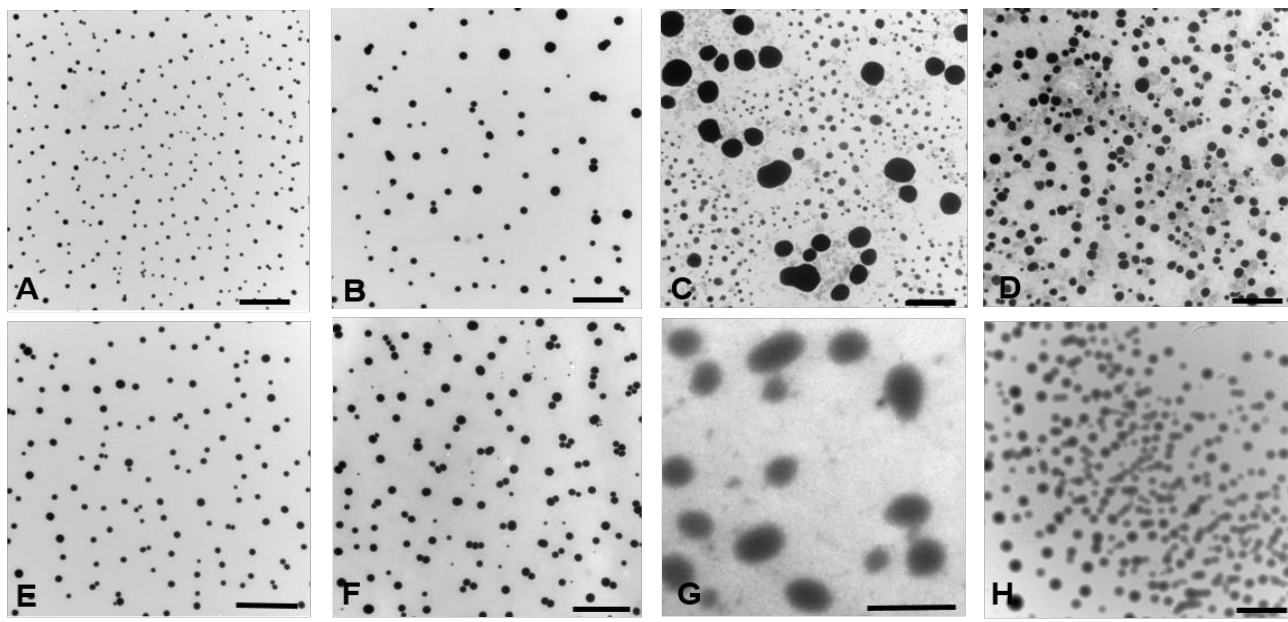
Figure 2. TEM micrographs of T1307:F127 ( A ), T1307:F127/FNZ ( B ), F127:LPS ( C ), F127:LPS/FNZ ( D ), F127-Glu ( E ), F127-Glu/FNZ ( F ), T1307-Glu ( G ) and T1307-Glu/FNZ ( H ). Note: Magnification: 6000×, except ( G ) 185,000×. Scale bars: 2 µm. Inset: average size distribution and Gaussian fitting of nanoparticles.